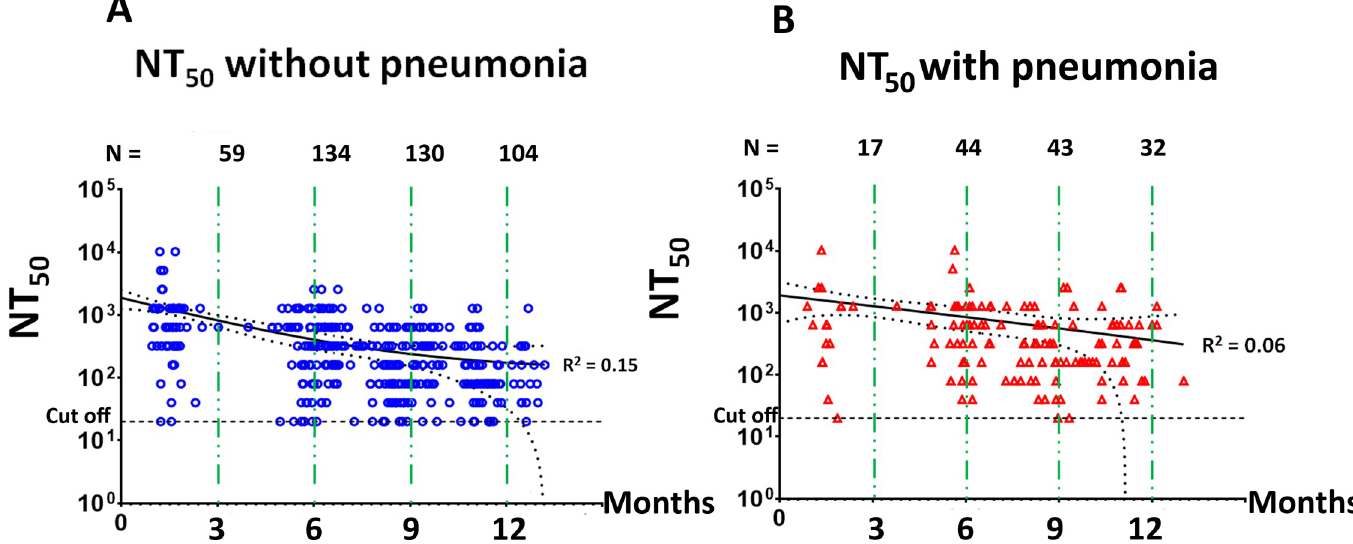
Fig 5. SARS-CoV-2 neutralizing titer in a longitudinal cohort of recovered COVID-19 patients who provided blood samples for at least three time-points. ( A) in the ‘without pneumonia’ group, (B) in the ‘with pneumonia’ group.